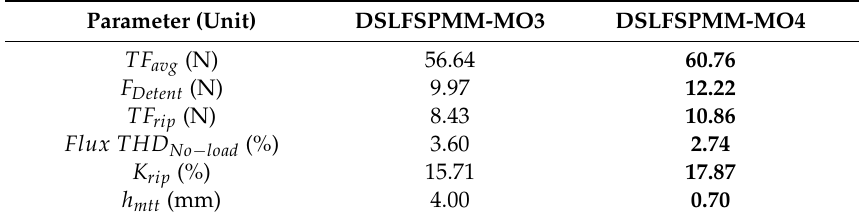
Table 10. Modified parameter and performance comparison of DSLFSPMM-MO3 with DSLFSPMM-MO4.